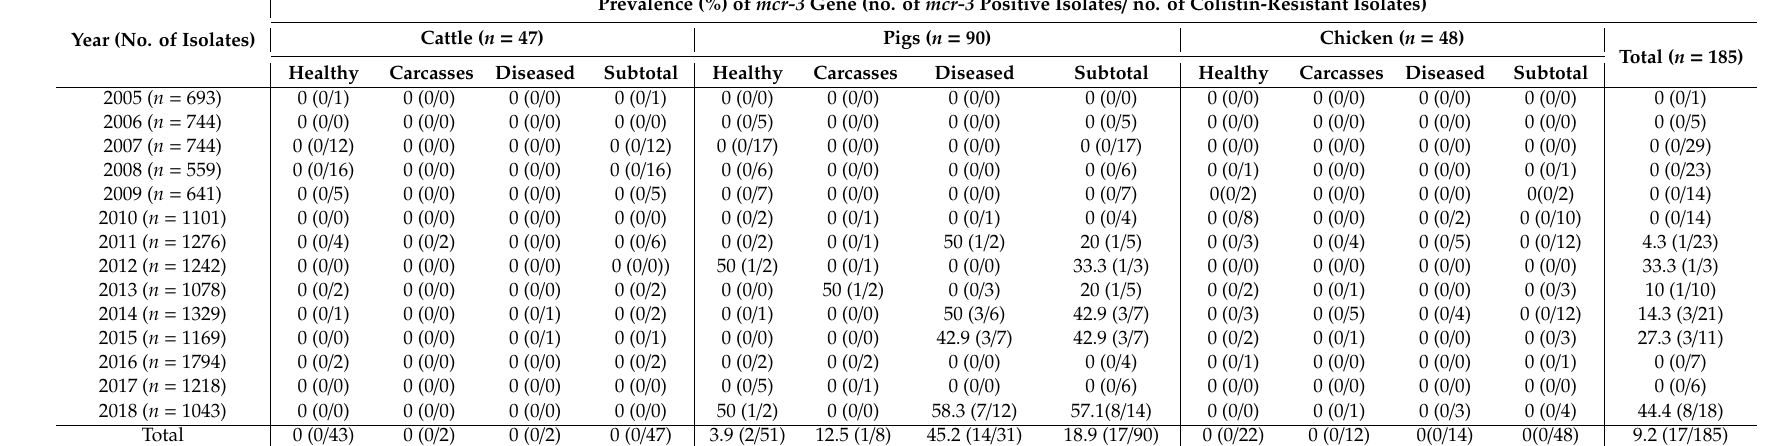
Table 1. Prevalence of mcr - 3 in colistin-resistant Escherichia coli obtained from food-producing animals and animal carcasses from Korea.